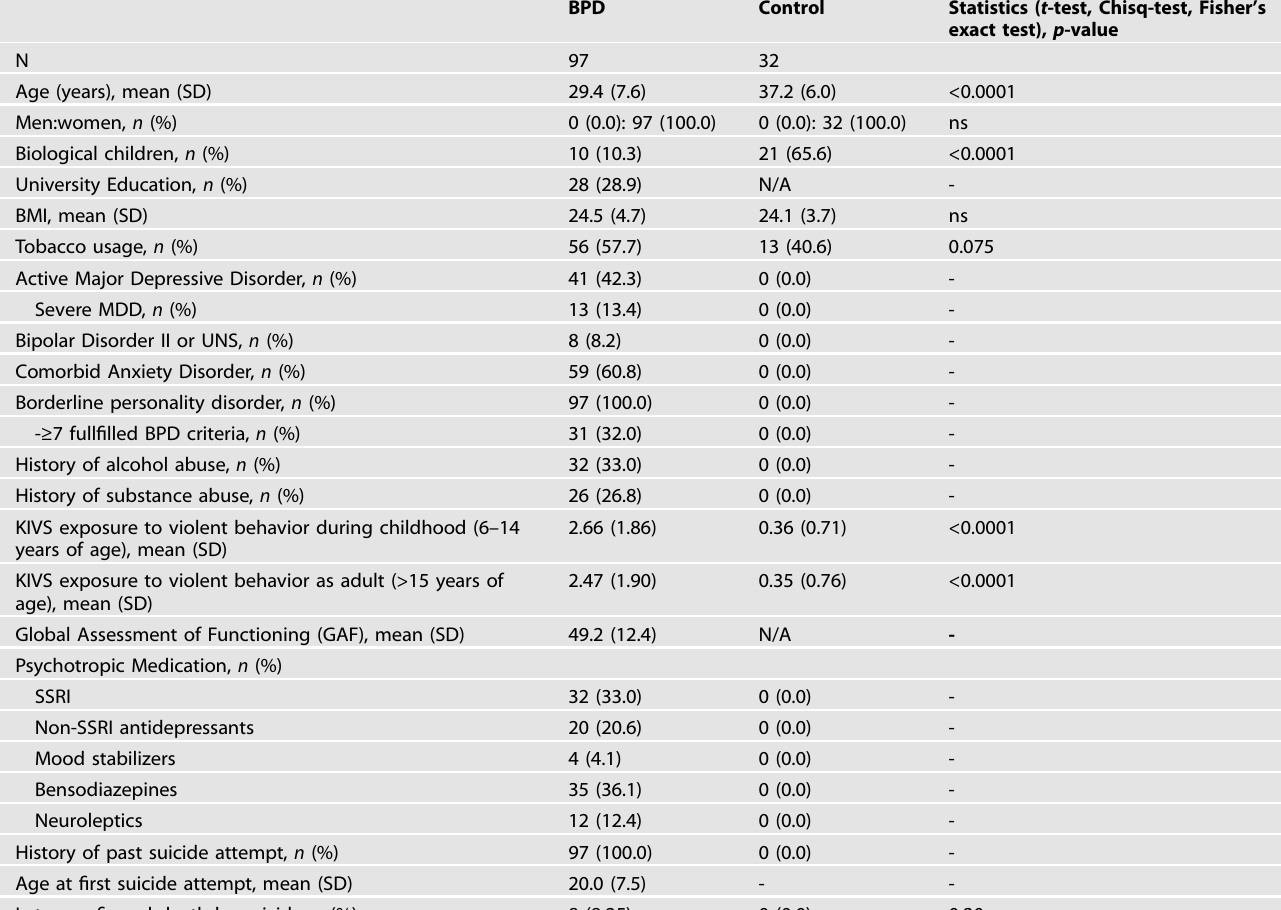
Table 1. Characteristics of